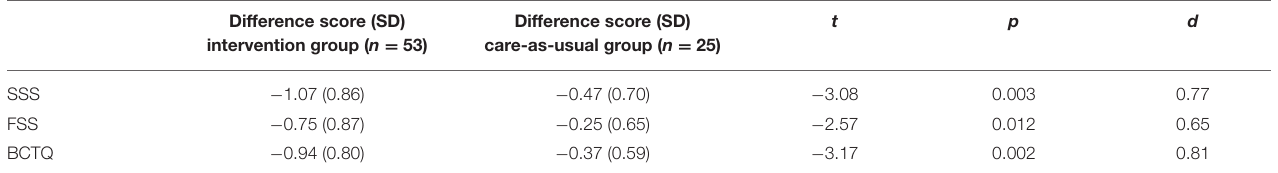
TABLE 2 | Comparison of the difference in BCTQ scores between baseline and the 12-month follow-up between the intervention and care-as-usual groups, excluding participants who had surgery. t Difference score (SD) Difference score (SD) intervention group ( n = 53) care-as-usual group ( n = 25)